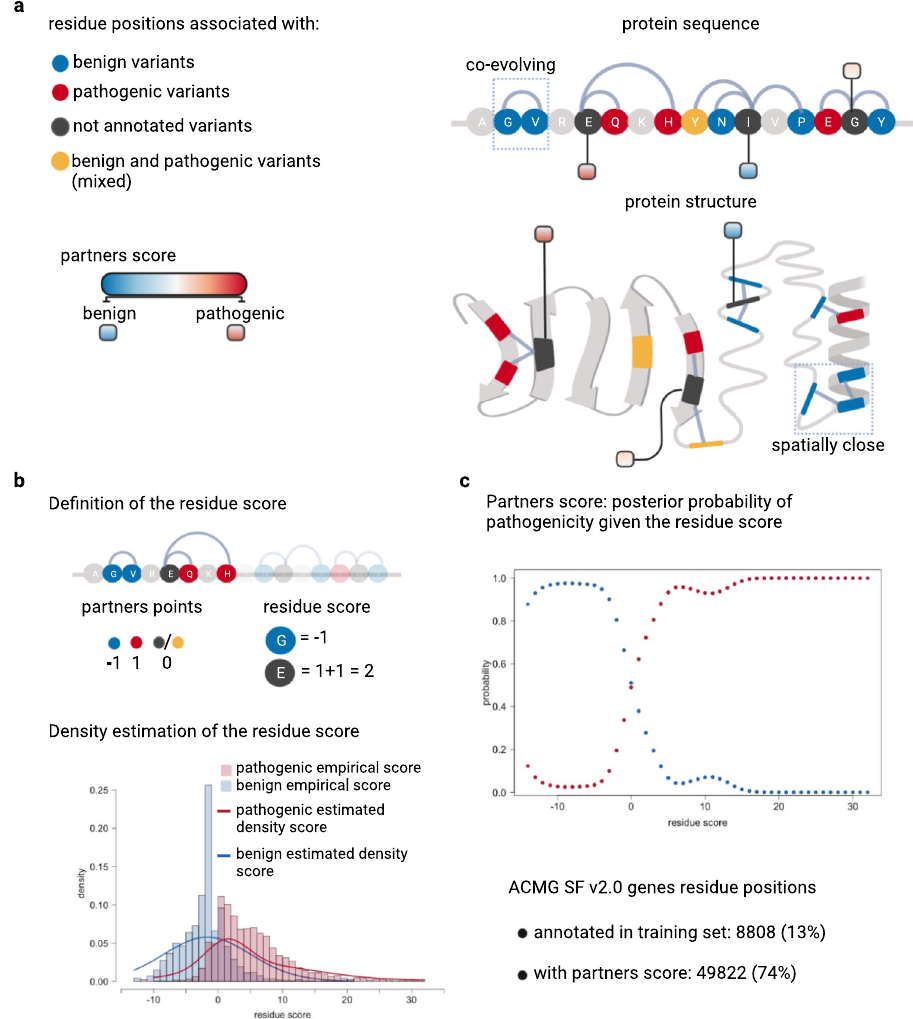
Fig. 2 | The partners score – integrating evolutionary and structural informa- tion to inform variant assessment. a Co-evolving residue pairs in the protein sequence and spatially adjacent residues (<11Å) in the protein 3D structure. Resi- dues are colored according to the phenotypic effect of associated variants within the DeMAG training set, e.g., red for positions with only pathogenic variants (see legend at left). The partners score informs residues positions that do not have any associatedvariantsbutareeitherco-evolvingorspatiallyclosetoresiduepositions thathavevariantswithknownphenotypiceffect(i.e.,annotatedinthetrainingset). b A point scale quanti fi es the connection between residue positions e.g., benign positions are assigned − 1, pathogenic 1, and mixed or not annotated 0. Next, we de fi ned the residue score as the sum of partners points per residue e.g., residue